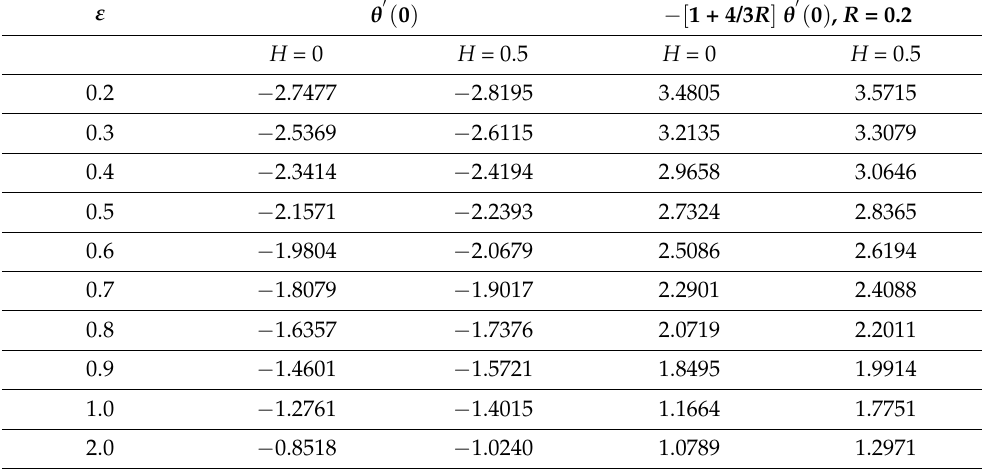
Table 20. Impact of variable thermal conductivity on Nusselt number with and without heat generation.